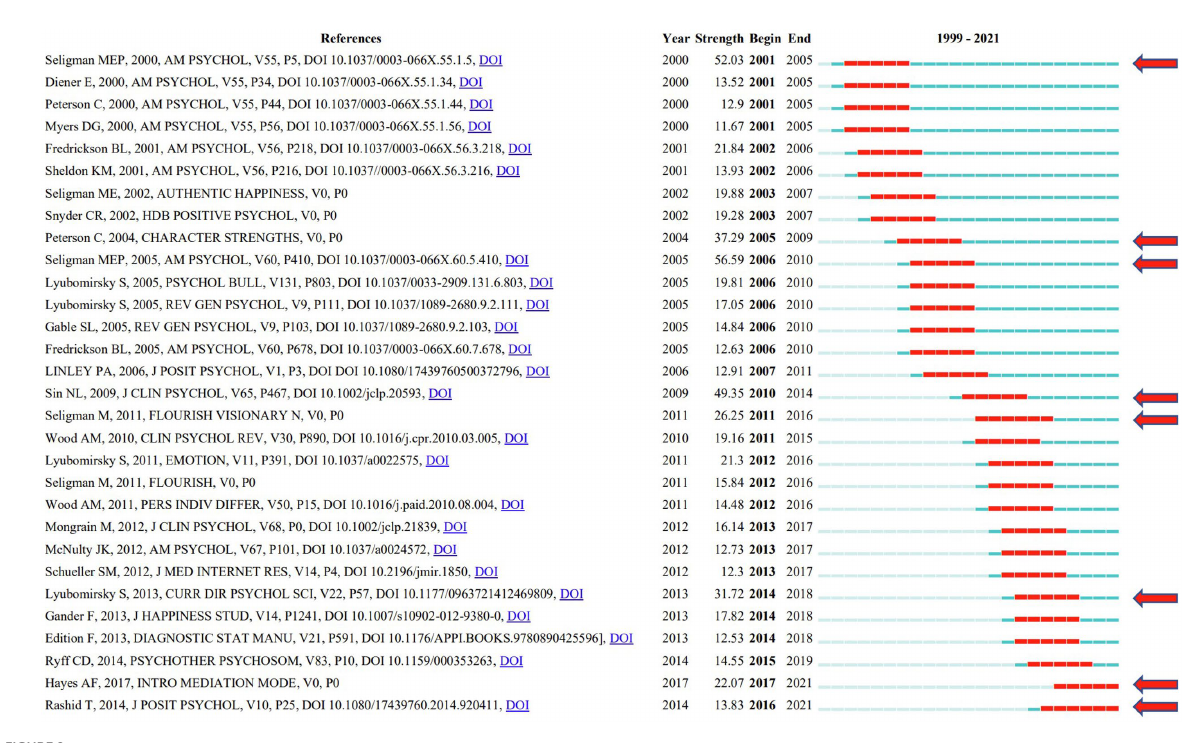
FIGURE 9 Top 30 references with strong citation bursts in positive psychology